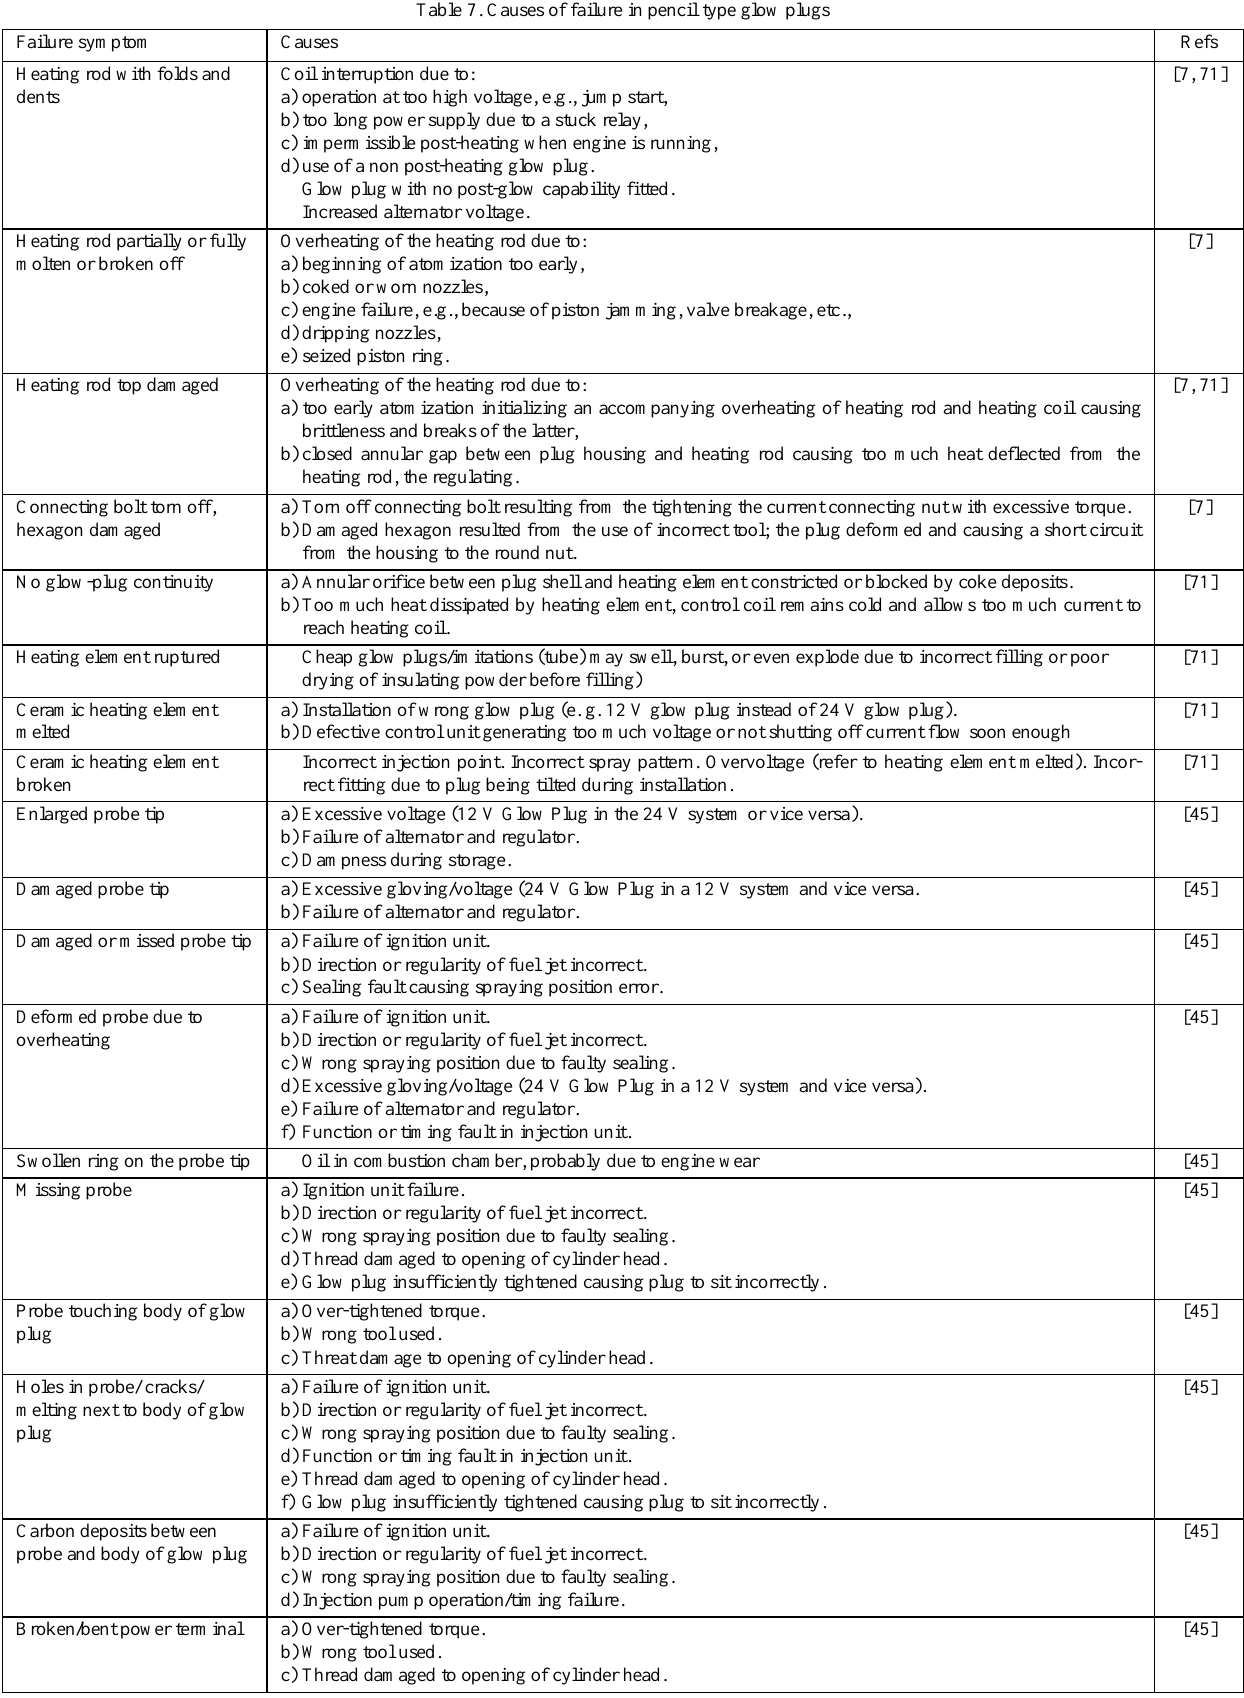
Table 7. Causes of failure in pencil type glow